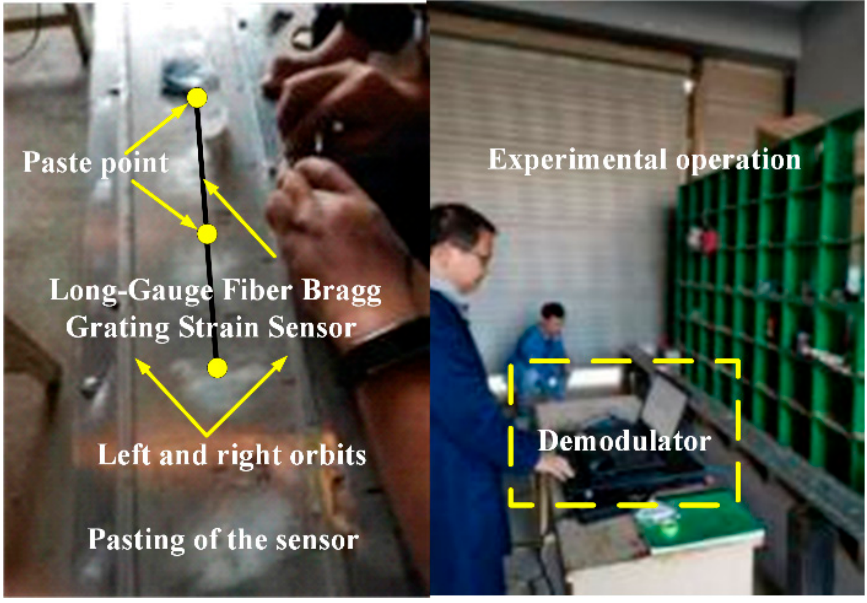
Figure 6. Sensor installation and experimental operation.